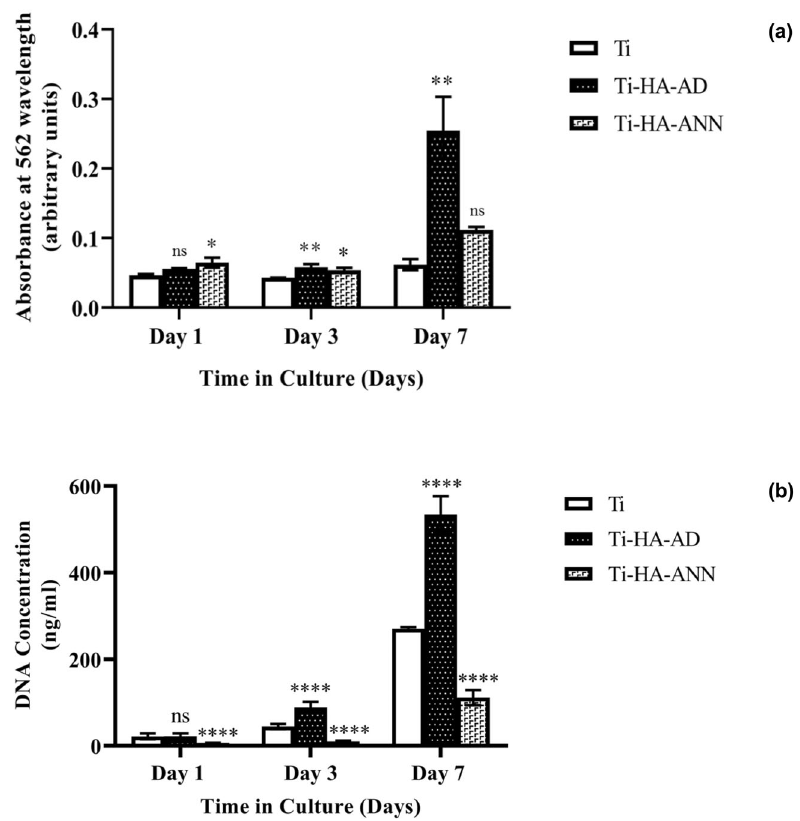
Fig. 3 a MTT assay results representing cell metabolic activity for U-2 OS cells and b PG assay results representing DNA concentration for U-2 OS cells adhered to three types of Ti substrates (i) TI, (ii) TI-HA-AD and (iii) TI-HA-ANN, see legend, and cultured under standard conditions for 1, 3, and 7 days. Each substrate type was tested in triplicate. Error bars represent standard deviation. Any statistical signi fi cance between cells seeded and cultured on TI to those on two types of HA-coated Ti substrates (TI-HA-AD and TI-HA-ANN) represented by; not signi fi cant (ns) where p > 0.05, signi fi cant where P < 0.05. Increasing signi fi cance represented by increasing number of asterisks (* P < 0.05, ** P < 0.01, ***P < 0.001 and **** P <